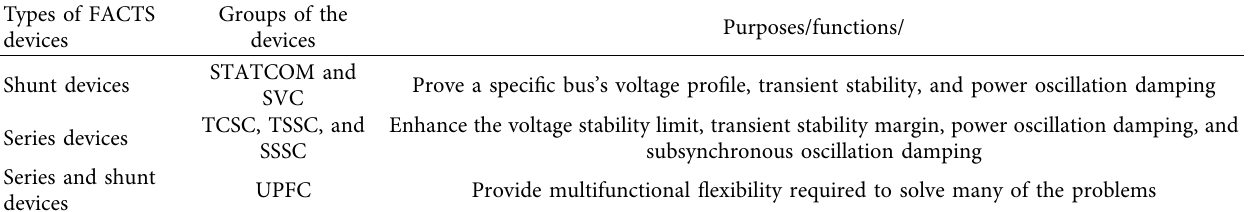
Table 1: Classification of FACTS